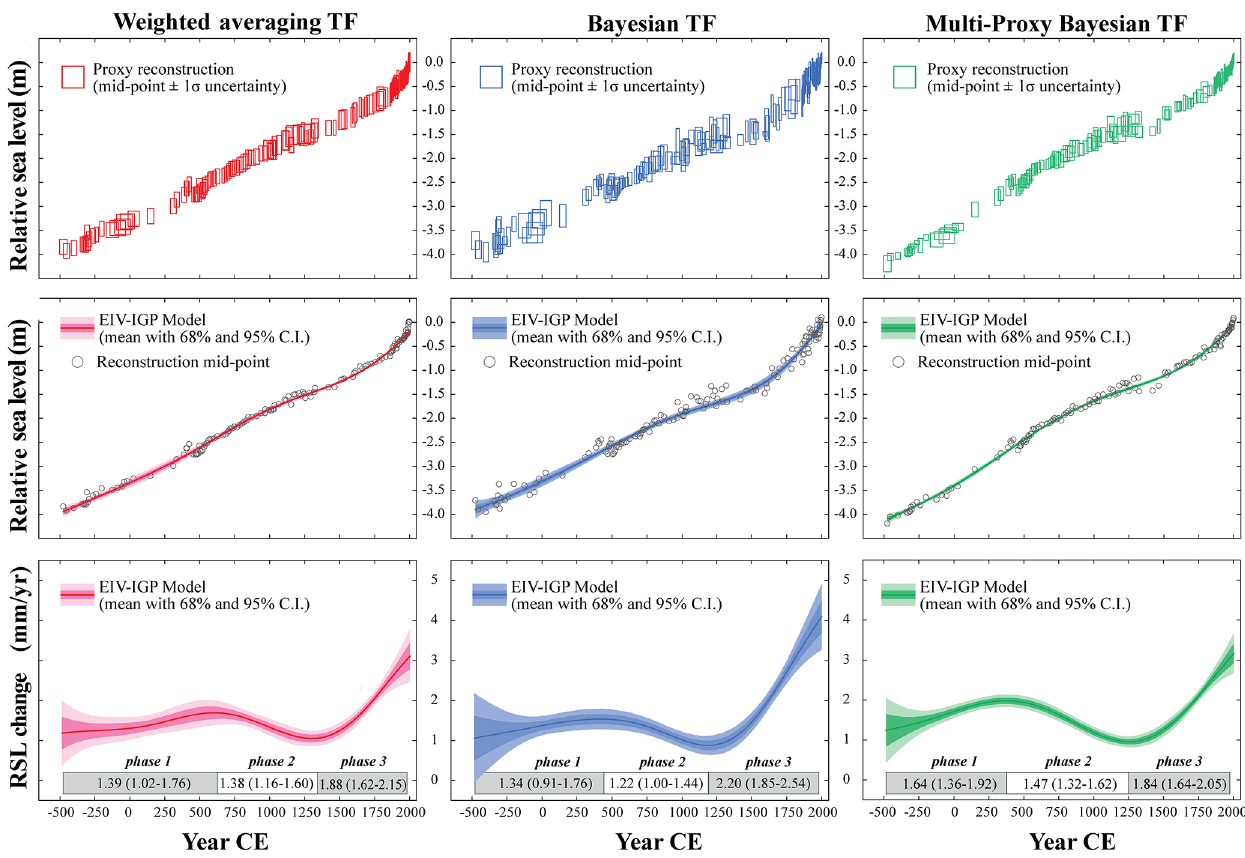
Figure 6. The EIV-IGP model results for reconstructions produced using the Bayesian transfer function (B-TF), the weighted averaging transfer function (WA-TF) and the multi-proxy Bayesian transfer function. The upper panel shows individual data points (represented by rectangular boxes that illustrate the 95% confidence region) and include age and relative sea-level uncertainties. The middle panels show the posterior fit of the Errors-In-Variables integrated Gaussian process model to the relative sea-level reconstructions. Solid line represents the mean fit with the 68 and 95% confidence intervals (C.I.) denoted by shading. The lower panels are the rates of relative sea-level (RSL) change. Shading denotes 68 and 95% confidence intervals (C.I.) for the posterior mean of the rate process. The average rate for each phase of the reconstruction is given (in mmyr − 1 ) with a 95% confidence